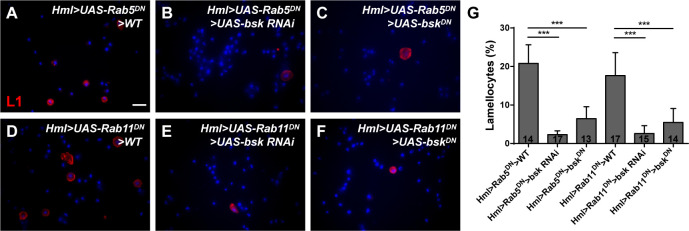
Repressing JNK signaling restored the increased lamellocyte count in Hml>UAS-Rab5/11DN larvae.(A–F) The increased lamellocyte counts were restored in Hml>UAS-Rab5/11DN>UAS-bsk RNAi (B, E) and Hml>UAS-Rab5/11DN>UAS-bskDN (C, F) circulating hemocytes. The quantification of lamellocytes is shown in (G). Scale bar: 20 μm. ***p<0.001 (one-way ANOVA).